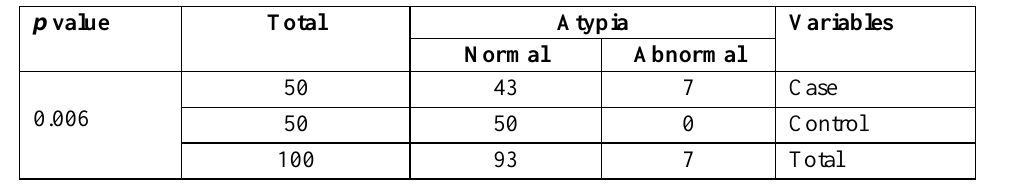
Table 6. Frequency of atypia among studied groups.